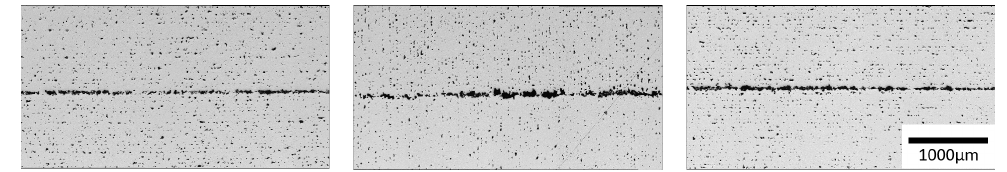
Figure 13. Formed sintered joint of two upper surfaces ( left ), two side surfaces ( middle ) and two bottom surfaces ( right ).